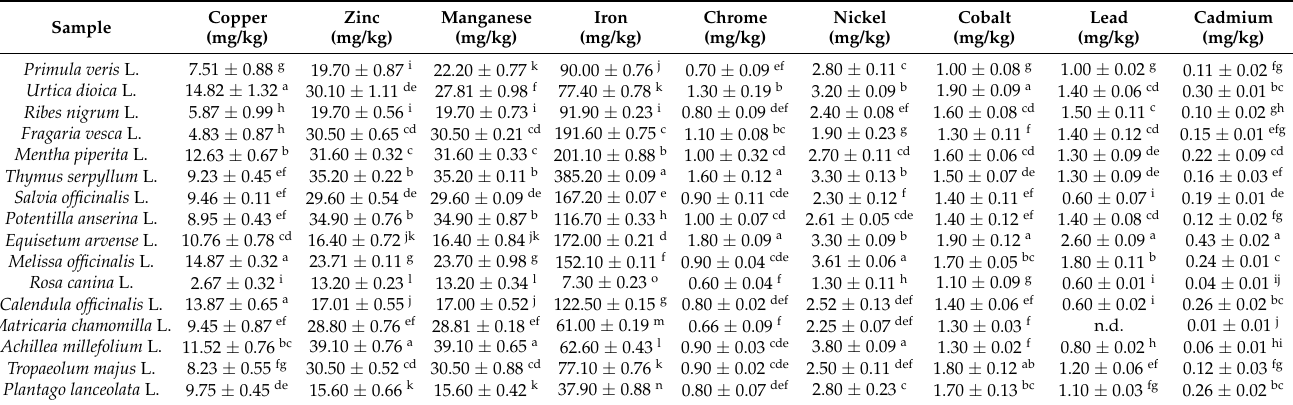
Table 3. The content of minerals in tested medicinal herbs (mg/kg dry